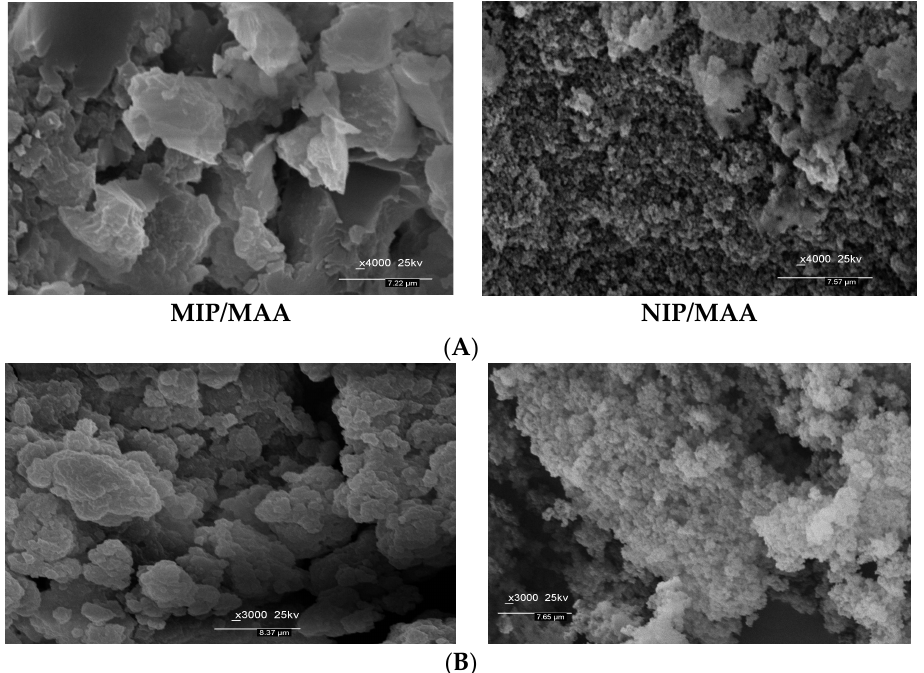
Figure 1. Scanning electon microscope(SEM) images of MIP and NIP using ( A ) MAA and ( B ) AA monomers.